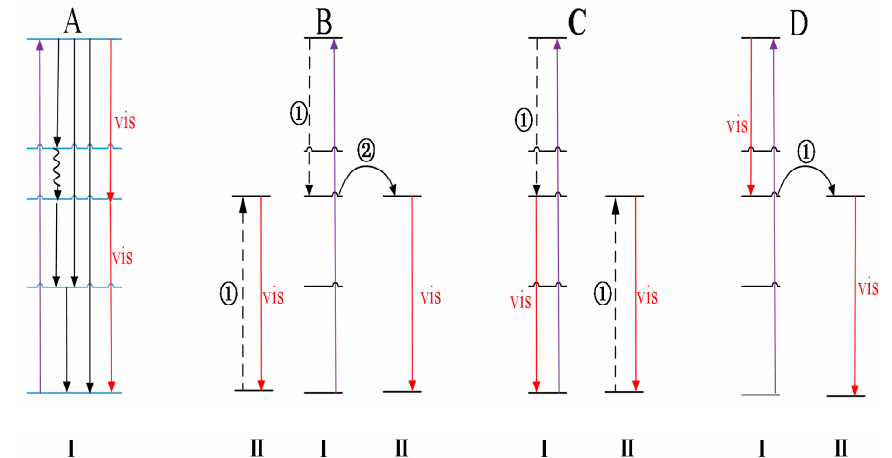
Figure 4. The schematic diagram of DC luminescence ( ① cross-relaxation ② energy transfer). ( A ) DC on a single ion by emission of two visible photons; ( B – D ) The possibility of DC on two ions. Reproduced with permission from [37]. The American Association for the Advancement of Science, 1999.